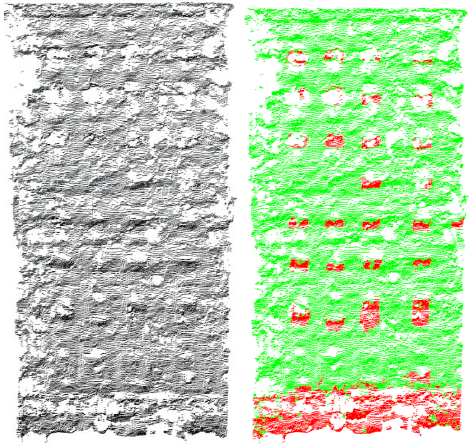
Figure 8. Low texture façade on the left and corresponding segmentation on the right